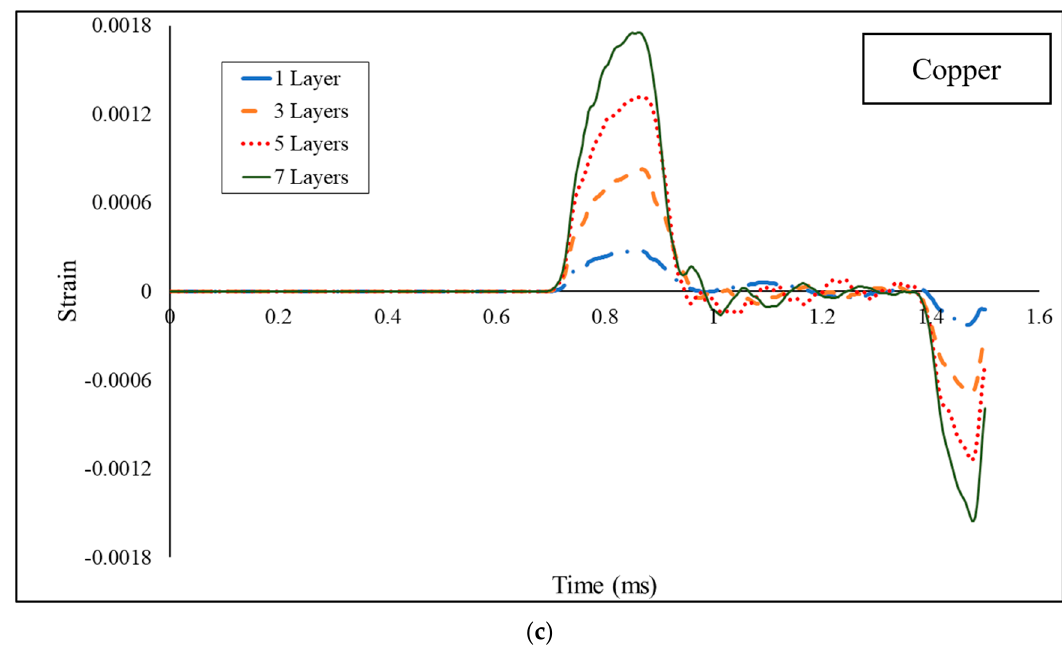
Figure 11. Strain wave on the transmitted bar with the effect of stacking on: ( a ) aluminum, ( b ) steel, and ( c ) copper.